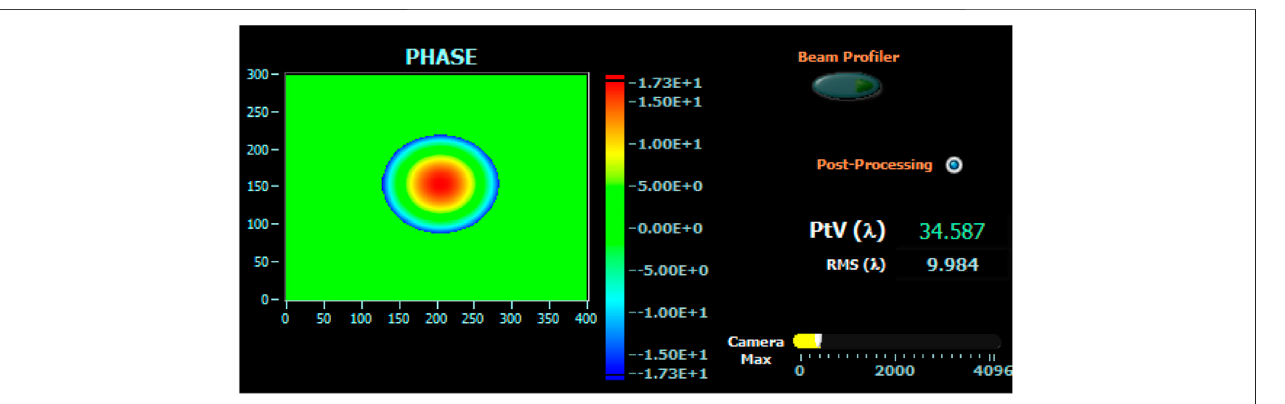
FIGURE 3 | Total defocus of the two pass ampli fi er.